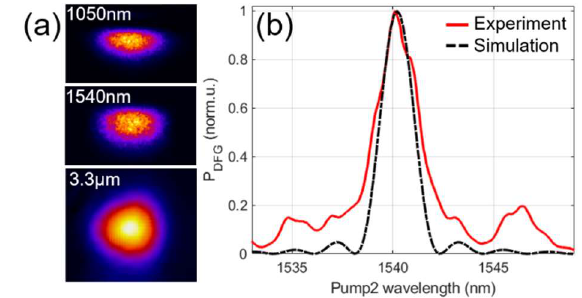
Fig. 4. (a) Experimentally measured Pump1, Pump2 and DFG mode intensities of the 13µm wide RPE PPLN ridge waveguide (b) Measured and simulated DFG tuning